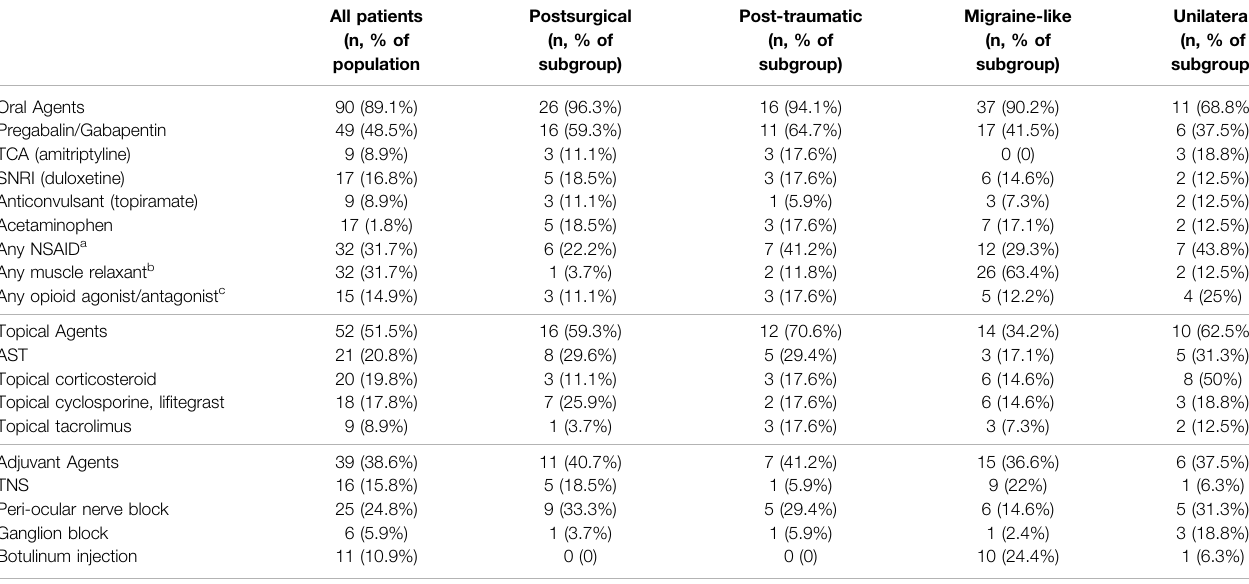
TABLE 2 | Utilized Oral, Topical, and Adjuvant Therapies, by Population and by.